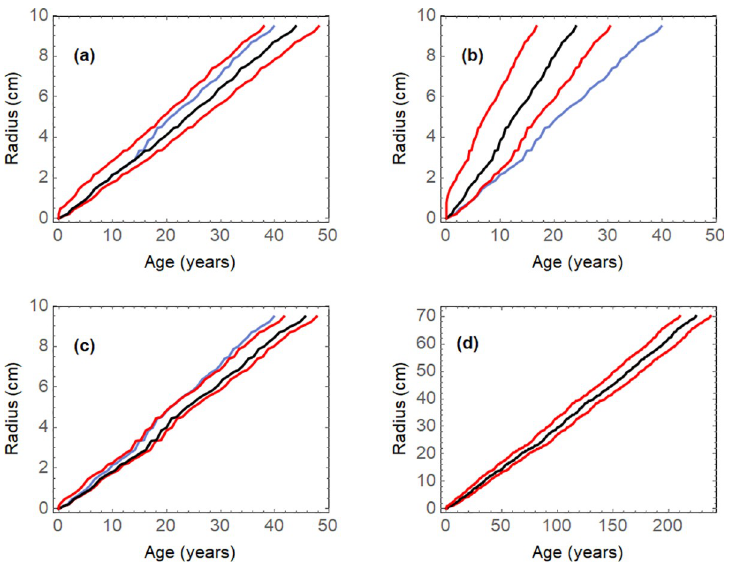
Fig 6. Simulations to analyze the sensitivity of the curves of radius as a function of expected age. (a) Four missing rings are assumed in the data of Fig 2; (b) The input probabilities are 0.5 instead of 0.83; (d) The input probabilities are 0.95 instead of 0.83; (d) Pseudorandom input probabilities between 0.5 and 1, and pseudorandom widths between 0 and 0.5 cm for 300